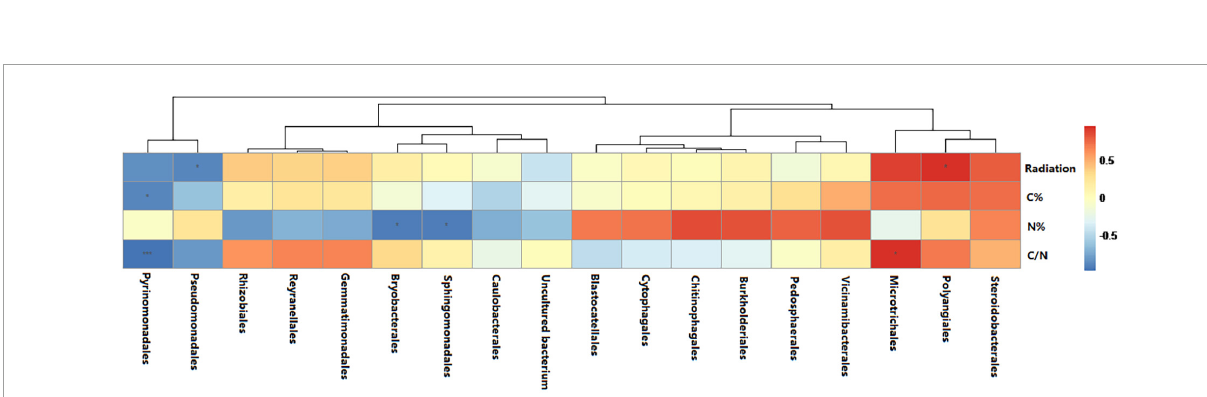
FIGURE6 Relationships between the dominant species (at order level) that exhibited higher relative abundance and the radiation intensity, carbon content, nitrogen content, and C/N ratio. The lines represent the relationships from cluster analysis of species/OTUs. Color depth represents the level of correlation. Significance: * < 0.05; *** < 0.001. Distance algorithm: Bray-Curtis, clustering method: